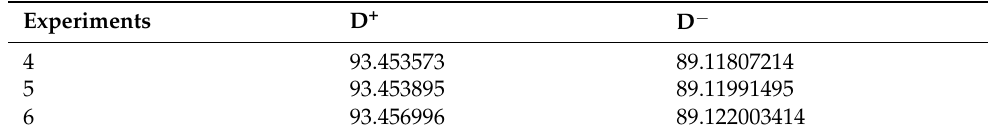
Table 14. Distance measures of alternatives from ideal solutions.